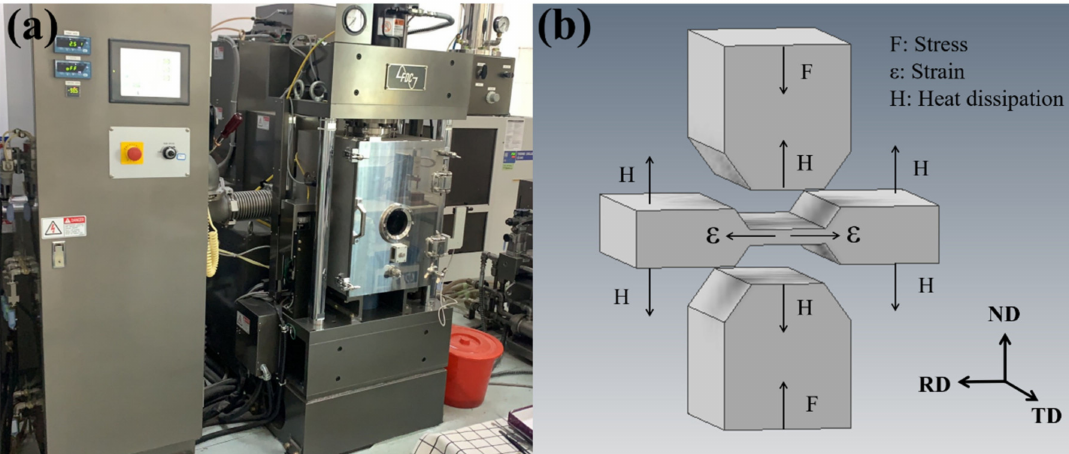
Figure 2. Experimental instruments and compression mode: ( a ) Thermecmastor-Z dynamic thermomechanical simulation testing machine, ( b ) schematic diagram of plane strain